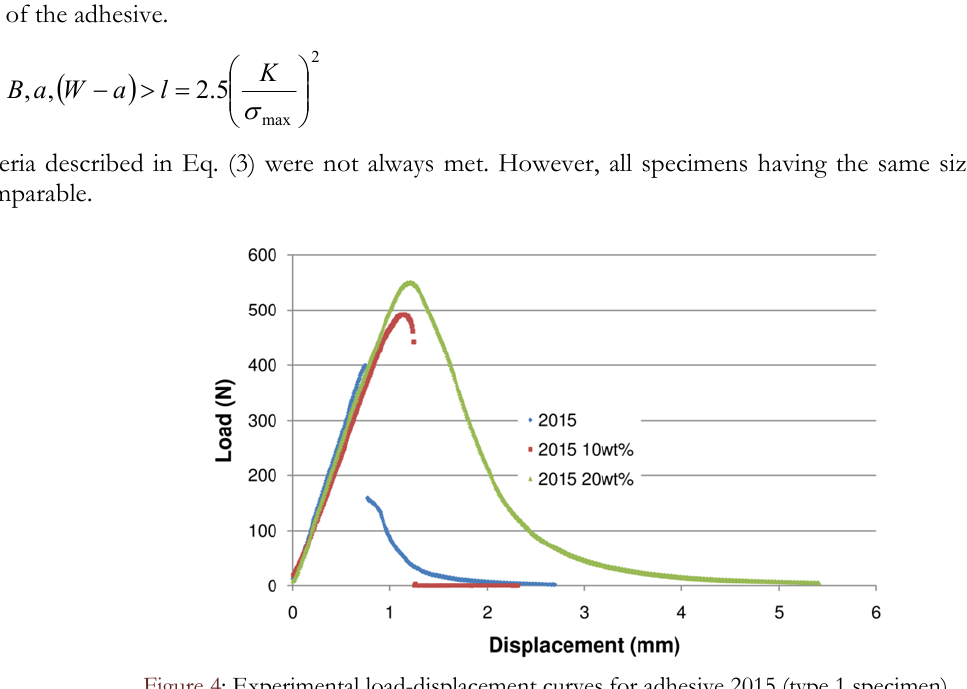
Figure 4: Experimental load-displacement curves for adhesive 2015 (type 1